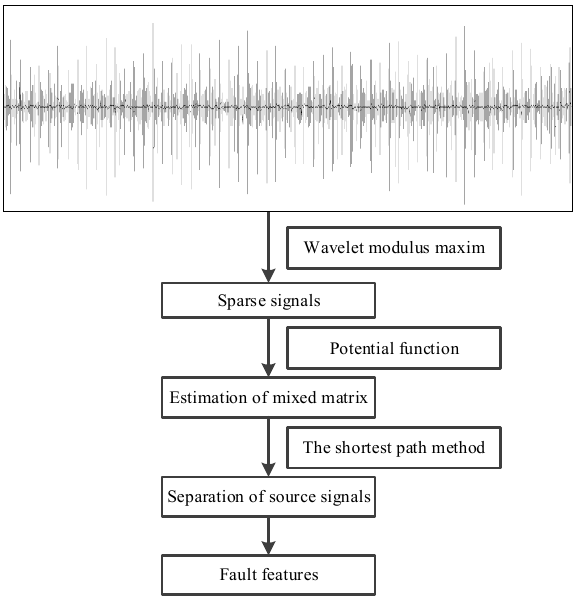
Figure 1. Flowchart of the proposed method.